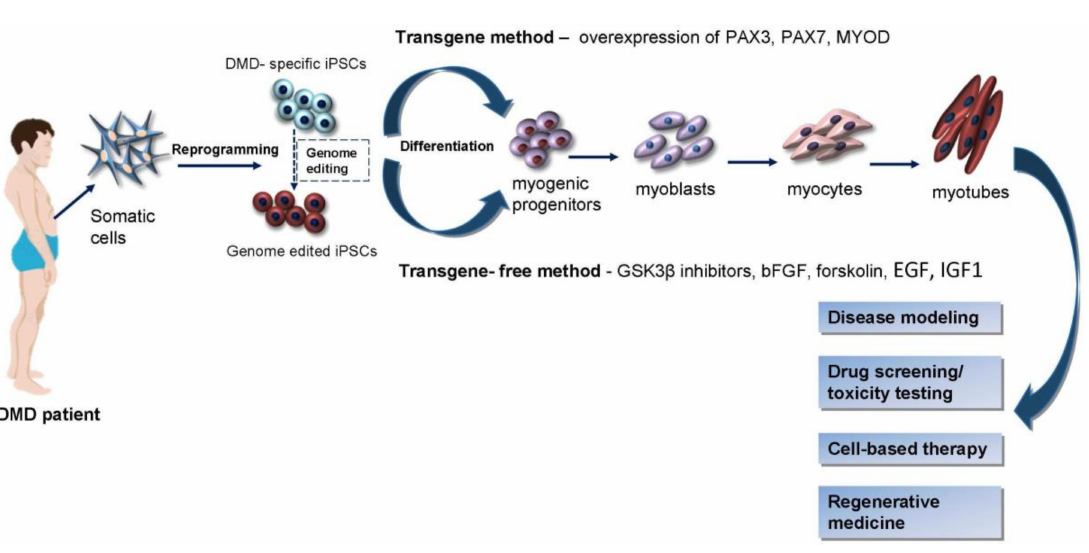
Figure 1. iPSCs potential for Duchenne muscular